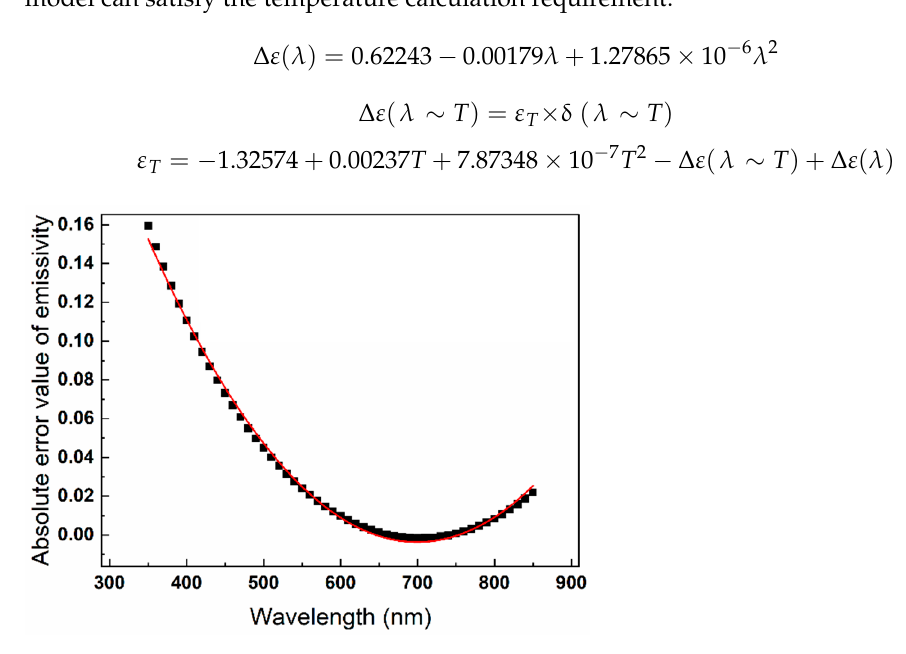
Figure 2. The absolute error value of emissivity with wavelengths. Table 1. The error analyzes the results of the emissivity model. Wavelength/nm